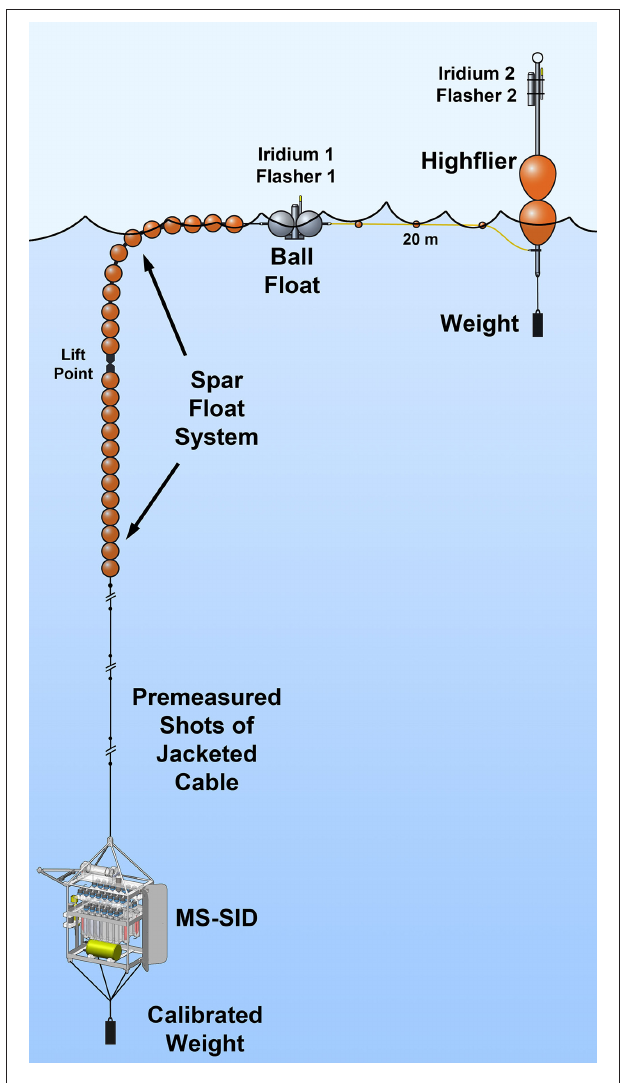
FIGURE 2 | The MS-SID as deployed on a free-drifting spar float system used in this study of ETSP OMZ protist grazing.